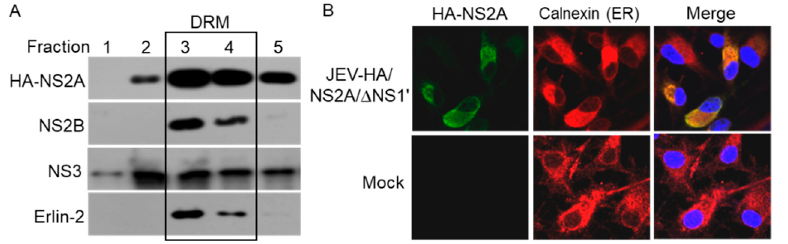
Figure 4. HA-NS2A localization to the ER. ( A ) BHK-21 cells were infected with JEV-HA/NS2A/ ∆ NS1’ and harvested at 48 hpi for an isolation of the detergent-resistant membranes (DRM). The presence of the indicated proteins in the DRM was detected by western blots. ( B ) BHK-21 cells were infected with JEV-HA/NS2A/ ∆ NS1’ and subjected to an immunofluorescence assay at 24 hpi. HA-NS2A (green) and the ER (red) were detected with anti-HA and anti-calnexin antibodies, respectively. The nuclei (blue) were stained with DAPI.